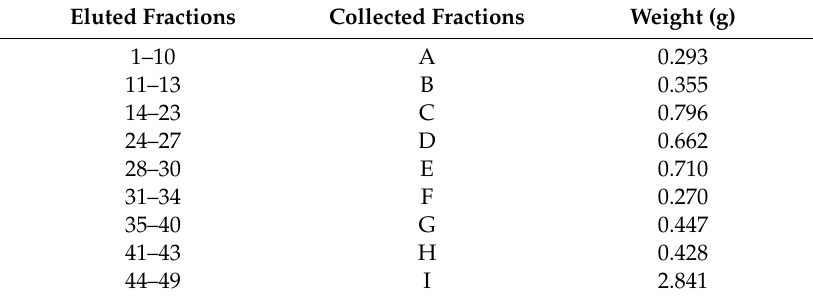
Table 1. Obtained fractions by silica gel column.